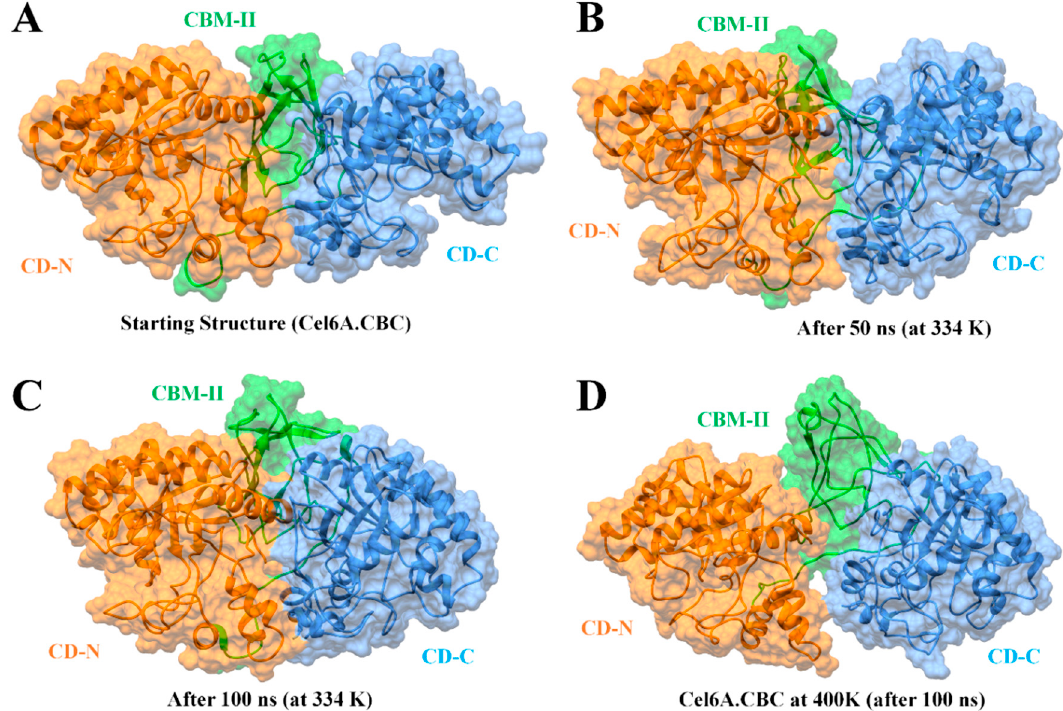
Figure 6. Molecular surface representation of Cel6A.CBC construct with catalytic domains are colored as orange at N-terminal (CD-N) and cauliflower at C-terminal (CD-C), while CBM-II connecting the catalytic domains is colored green. ( A ) The initial conformation of Cel6A.CBC before MD simulation. ( B ) The conformation of Cel6A.CBC at an optimum temperature of 60.85 °C after 50 ns. ( C ) The conformation of Cel6A.CBC at an optimum temperature of 60.85 °C after 100 ns. ( D ) The conformation of Cel6A.CBC at an extreme temperature of 126.85 °C after 100 ns.